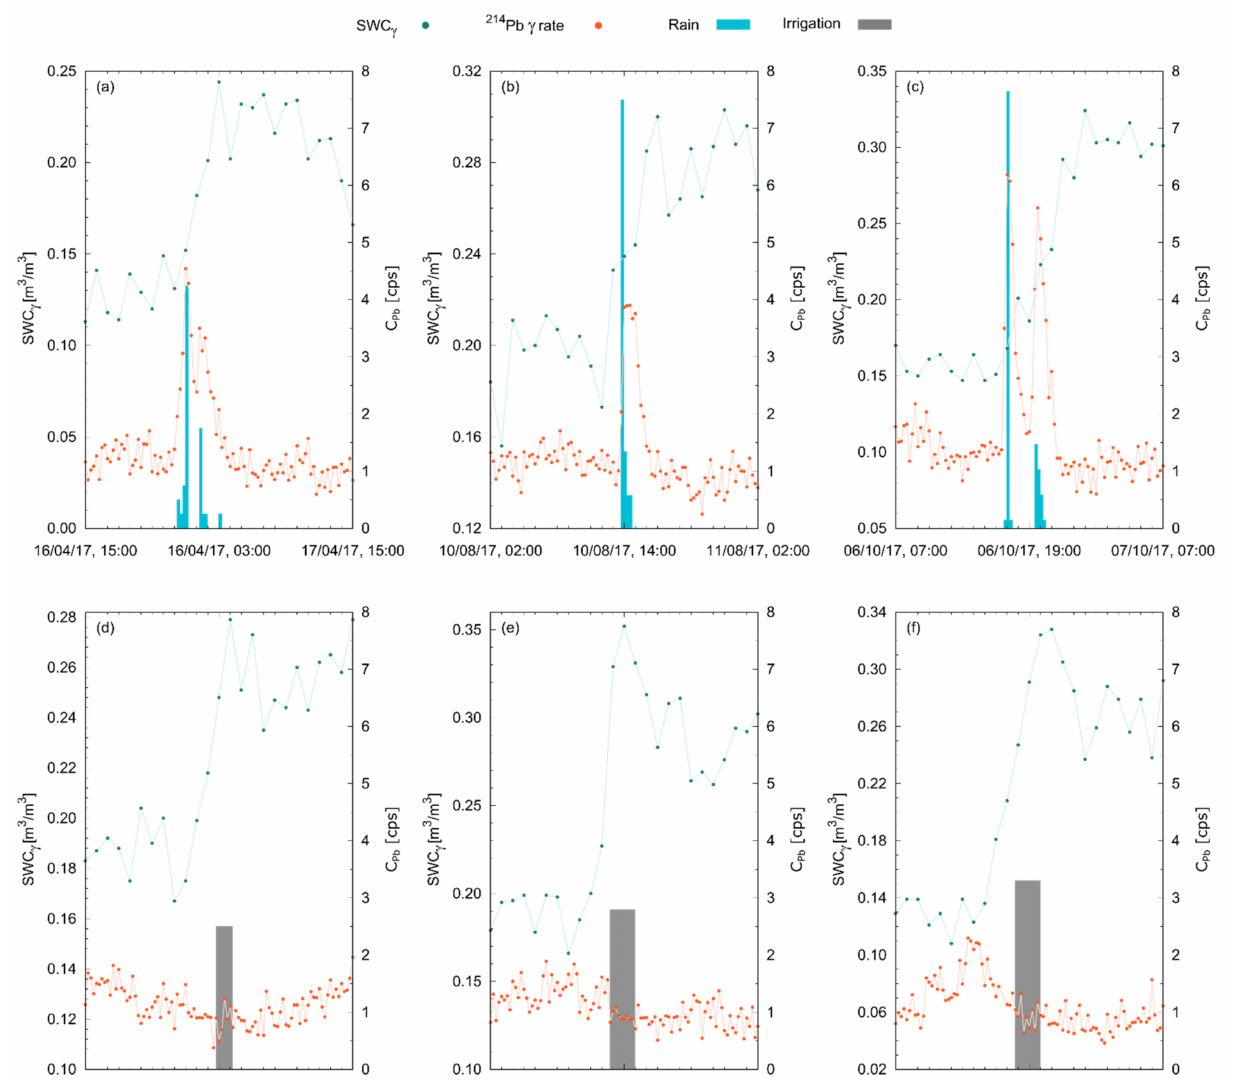
Figure 7. Temporal evolution of SWC γ (in green) and C Pb (in orange) during three rainfalls ( a – c ) and three irrigation events ( d – f ) occurred in T2017, modified after [36]. The SWC γ (in green) is hourly estimated, while the C Pb (in orange) and the water amount (in blue for rain and in gray for irrigated water) have a 15 min time